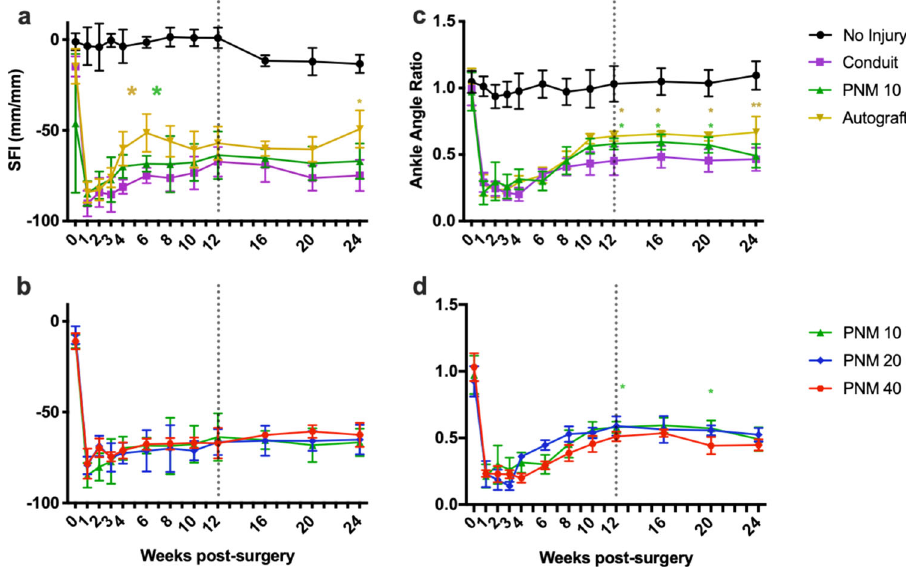
Fig. 4 Gait analysis via SFI and ankle angle measurements in experimental and NI groups normalized by their contralateral hind limb values. Vertical dotted line placed at the threshold for the piecewise statistical approach described in the methods section. a SFI over 24 weeks. Gold asterisks denote signi fi cance between autograft and PNM-10 and green asterisks denote signi fi cance between PNM-10 and conduit. b Ankle angle over 24 weeks. c SFI over 24 weeks for PNM groups. Gold asterisks represent signi fi cance when comparing autograft to PNM-10 and green asterisks represent signi fi cance when comparing PNM-10 to the conduit. d Ankle angle over 24 weeks for PNM groups. A green asterisk compares PNM-10 with PNM-40. P values <0.05 are denoted by *, p < 0.01 by **, p < 0.001 by ***, and p < 0.0001 by ****.